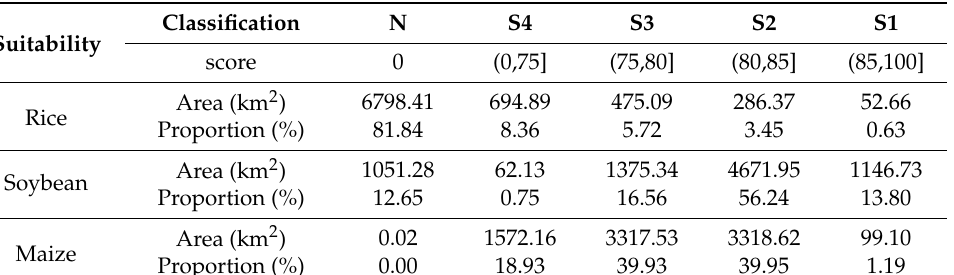
Table 3. Results of planting suitability classification of rice, maize, and soybean.